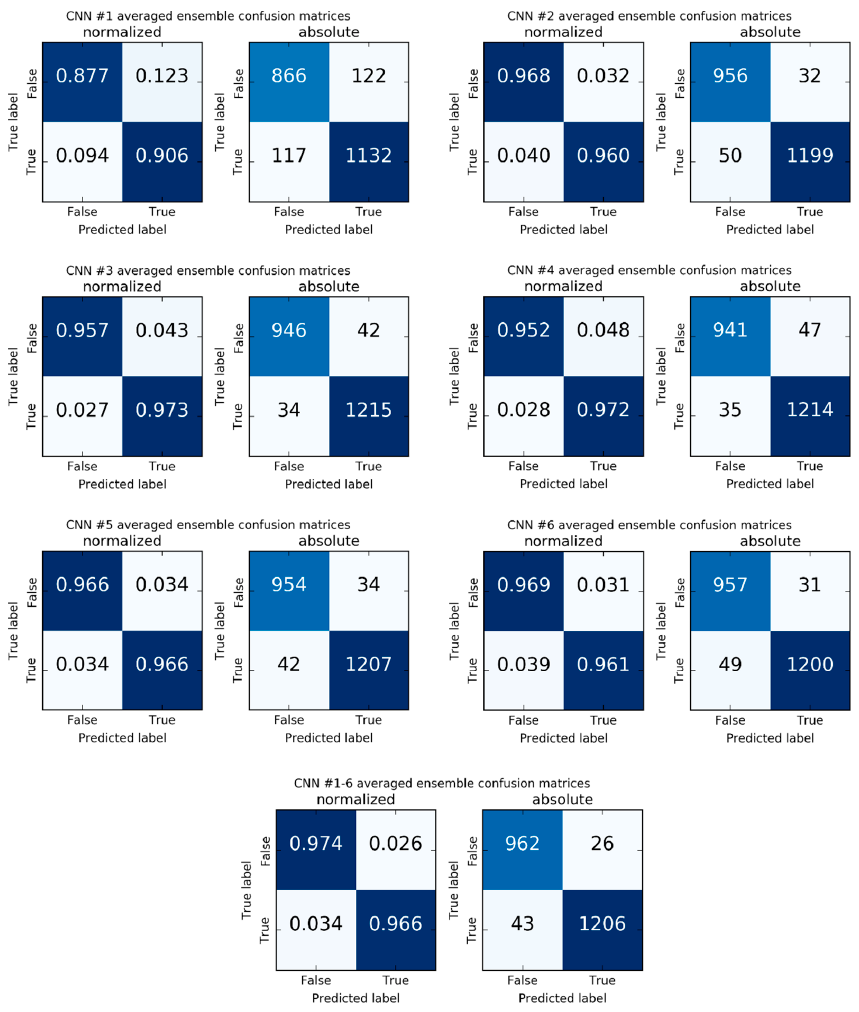
Figure A1. Confusion matrices for all models and the third-order model CNN #1–6 averaged ensemble, computed on test never-seen subset of data. For each architecture the ensemble averaging technique is applied.